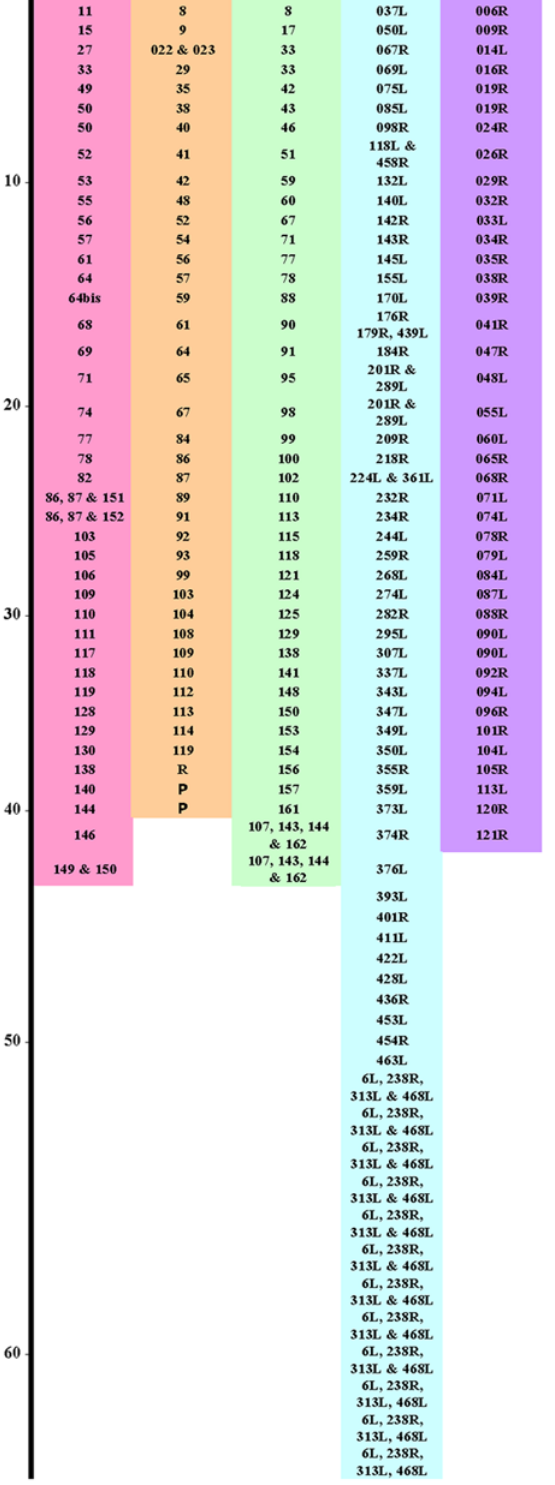
Figure 2. Graphic presentation of DpAV4a ORF homologues in the genomes of three ascoviruses (SfAV1a, TnAV6a, and HvAV3e) and two invertebrate iridoviruses ( Chilo iridovirus, CIV; and Mosquito iridovirus, MIV).